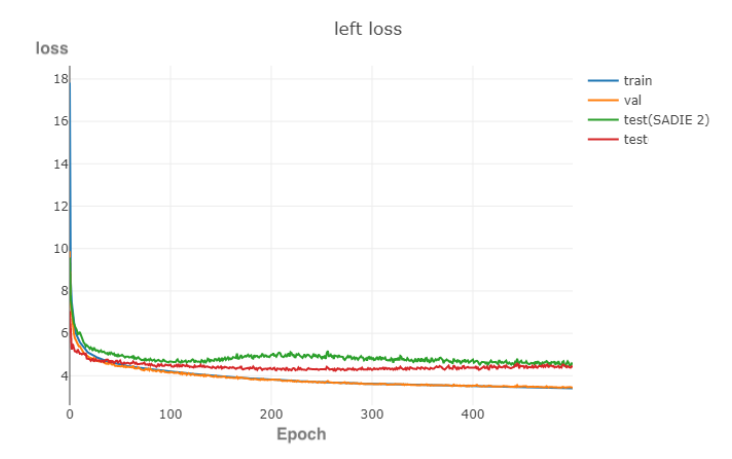
Figure 9. Left channel L1 loss during training (blue: training loss, orange: validation loss, green: hold out test data Subject 20 from SADIE II, red: Bernschutz KU100), which shows that the lowest point in the curve is at around 110 epochs.